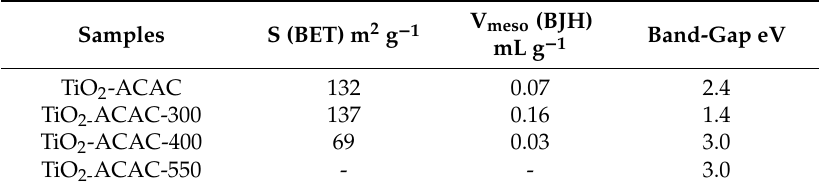
Table 2. Specific surface areas (S) calculated by Brunauer-Emmett-Teller (BET) approach, volumes of mesopores (V meso ) determined by Barrett-Joyner-Halenda (BJH) method and optical